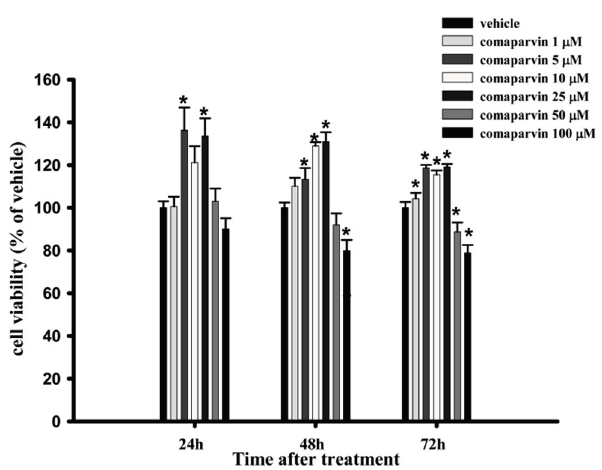
Figure 2. Effect of comaparvin on the viability of macrophage cells. Cells were incubated with different concentrations of comaparvin for 24, 48, and 72 h, and cell viability assessed using the alamar blue assay. Data from five independent experiments are presented as the mean ± SEM values. * p < 0.05 compared with vehicle groups.